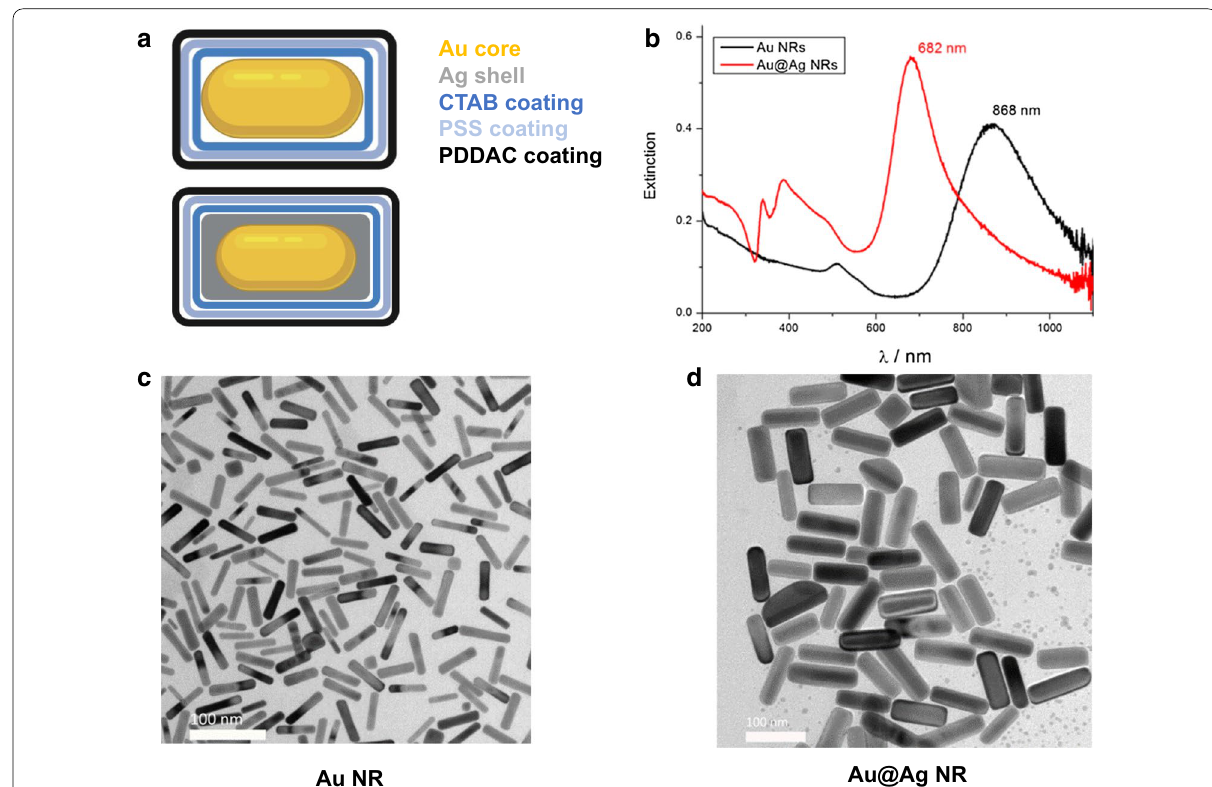
Fig. 1 Characterization of Au NR and Au@Ag NR. a Structural diagram of Au NR and Au@Ag NR; b UV–Vis–NIR extinction spectra of Au NR and Au@ Ag NR dispersed in water; c representative TEM images of Au NR; d representative TEM images of Au @Ag NR